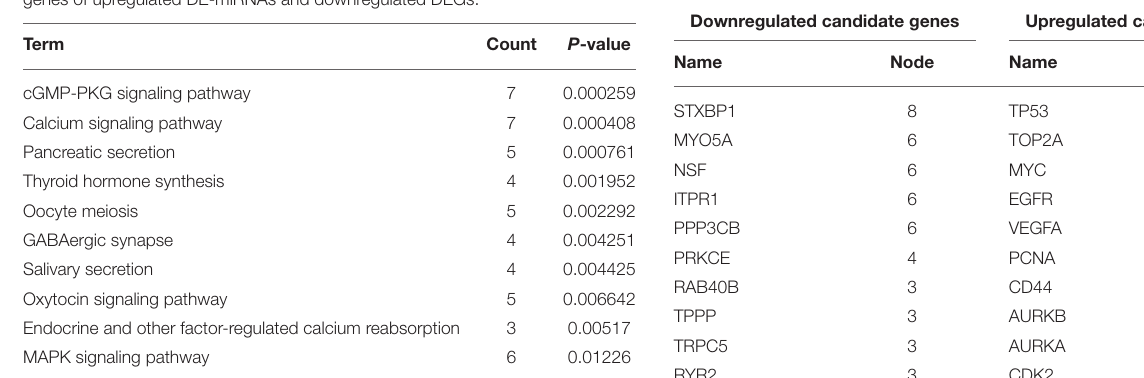
TABLE 3 | Hub genes in the PPI